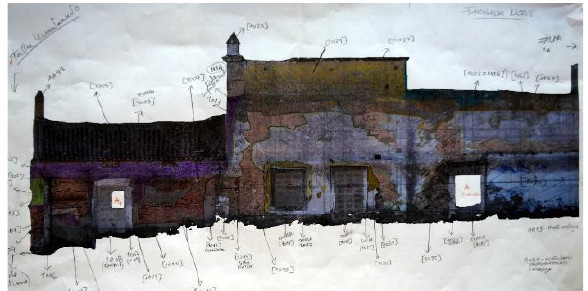
Figure 17. Archaeology field work